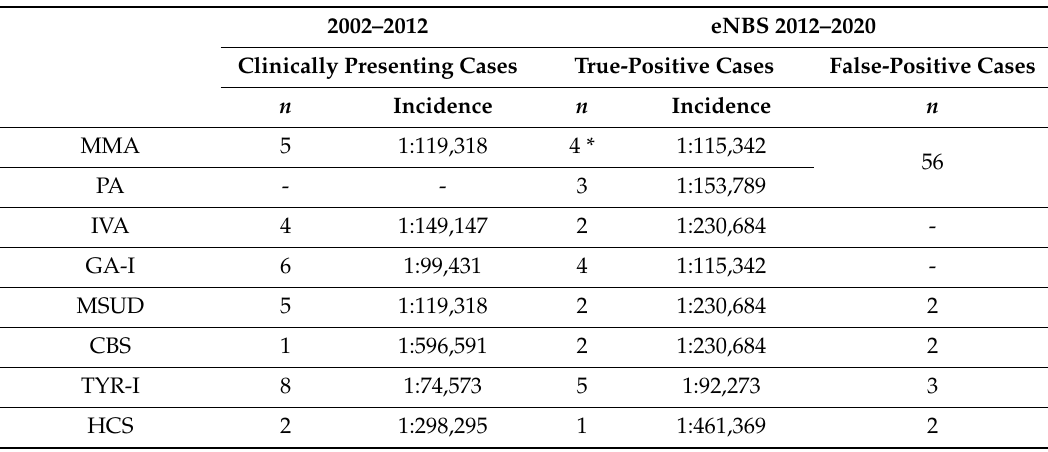
Table 2. NBS results for 20 metabolic conditions in an eight year period from 2012 to 2020 compared to clinically presenting cases born between 2002 and